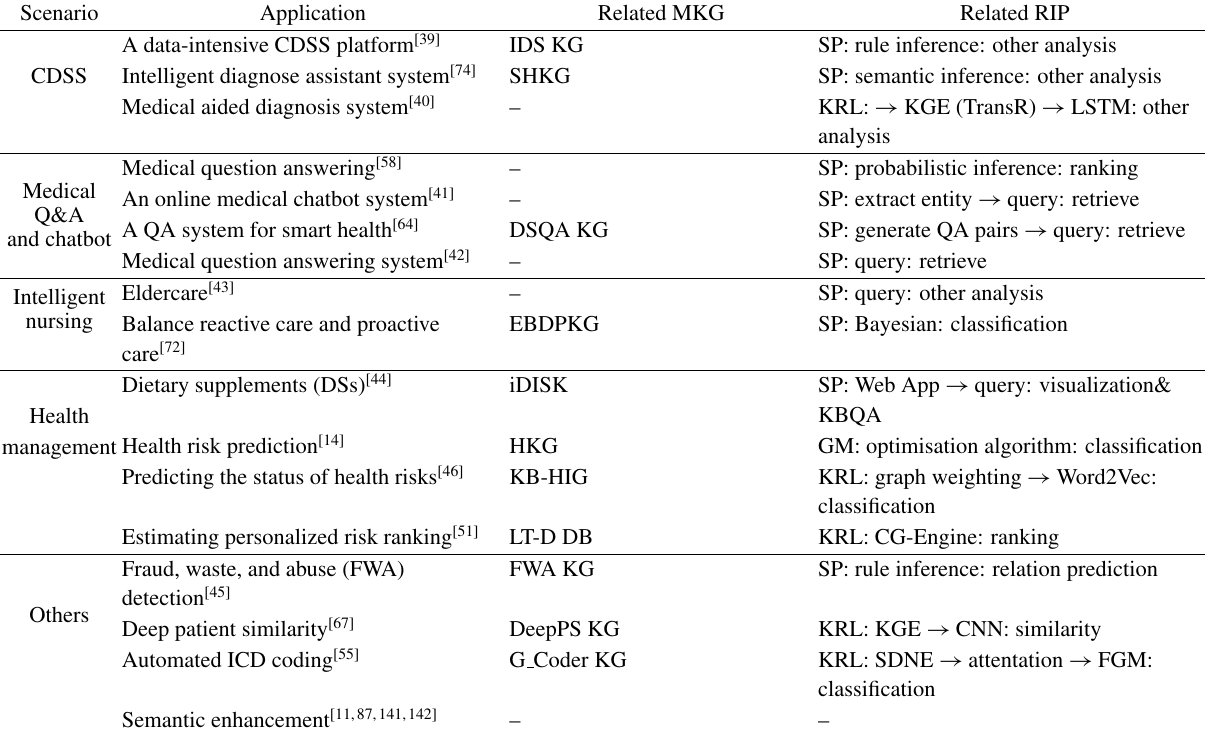
Table 4 Intelligent applications based on MKG and